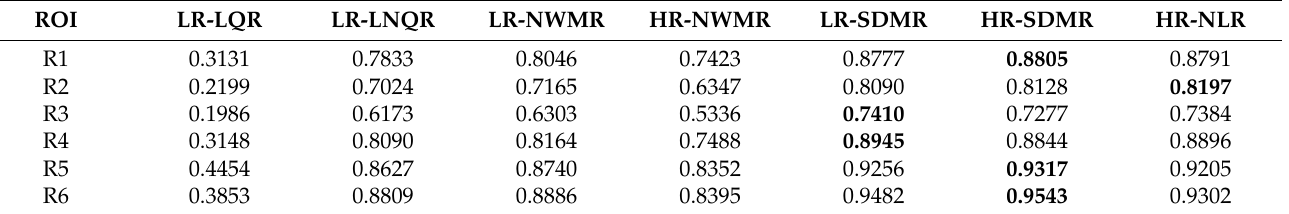
Figure 5. The six regions of interest for evaluating the regional performance of each algorithm used in Table 1. Table 1. Regional MCRCs for ROIs in Figure 5 evaluated from 50 independent noise trials. The bold values indicate the best